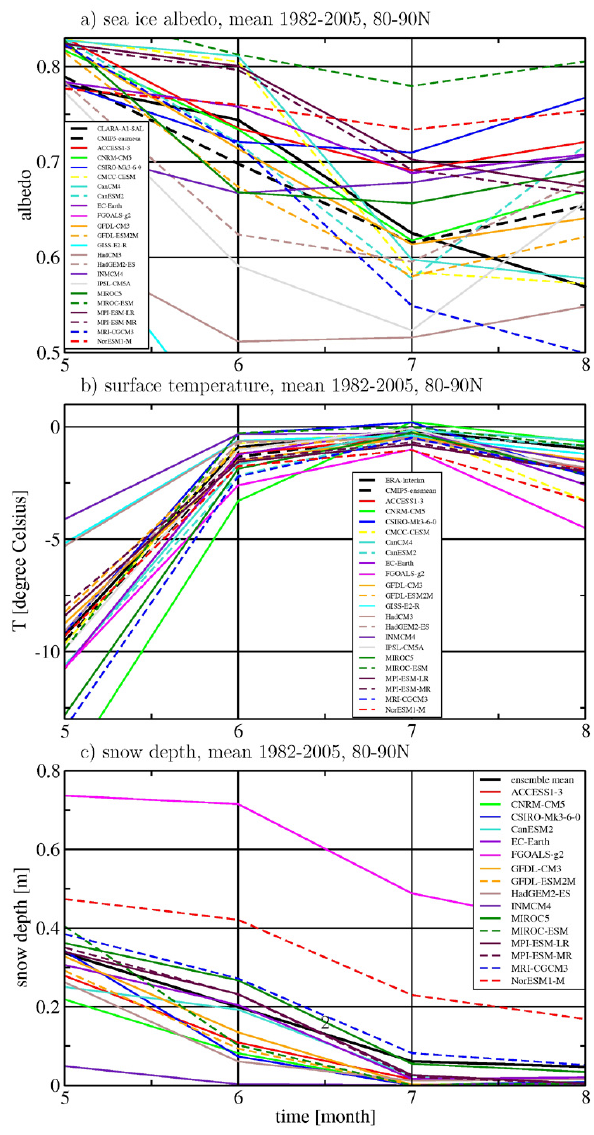
Fig. 9. (a) Time evolution of sea ice albedo through May to August, averaged over 80–90 ◦ N and 1982–2005. (b) The same as (a) for surface temperature. (c) The same (a) for snow